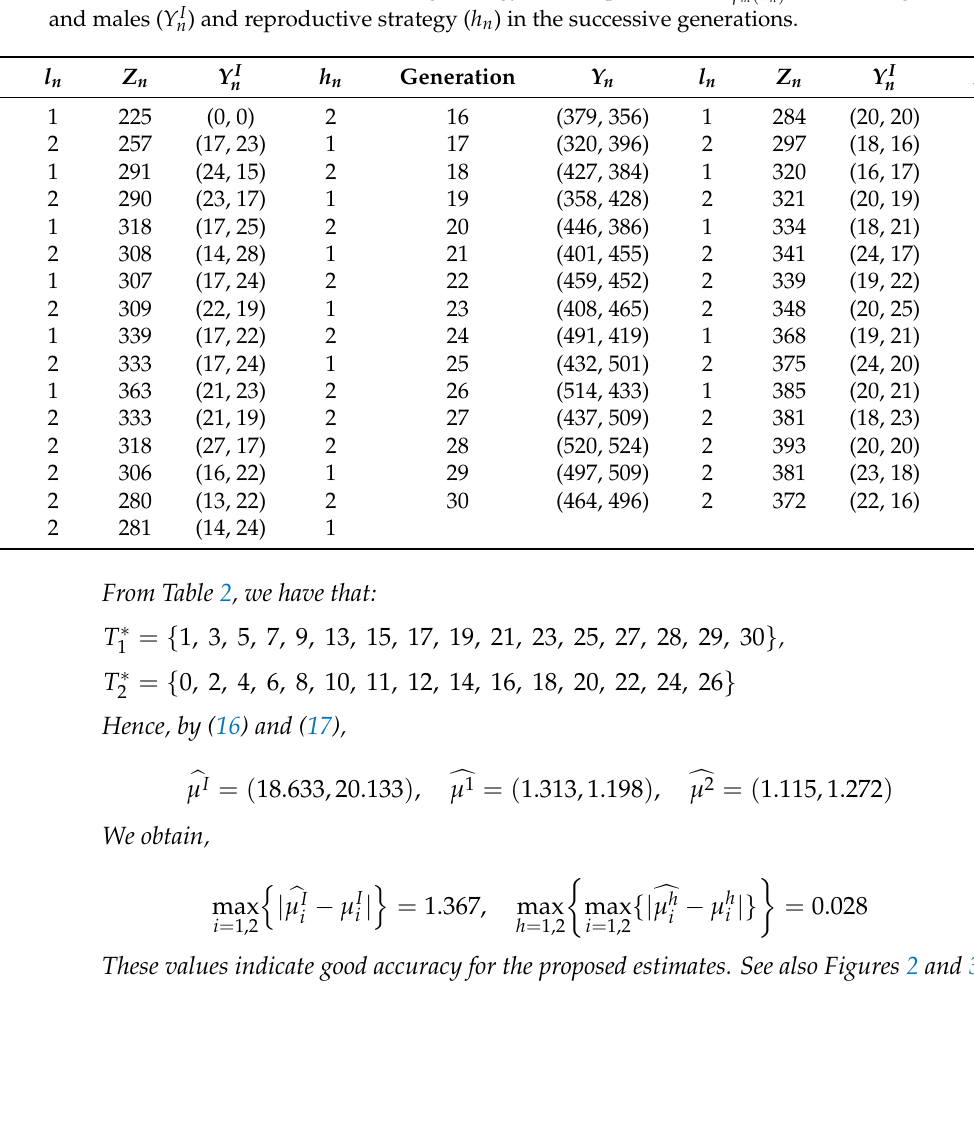
( Y n ) ), immigrant females m ( Y n )